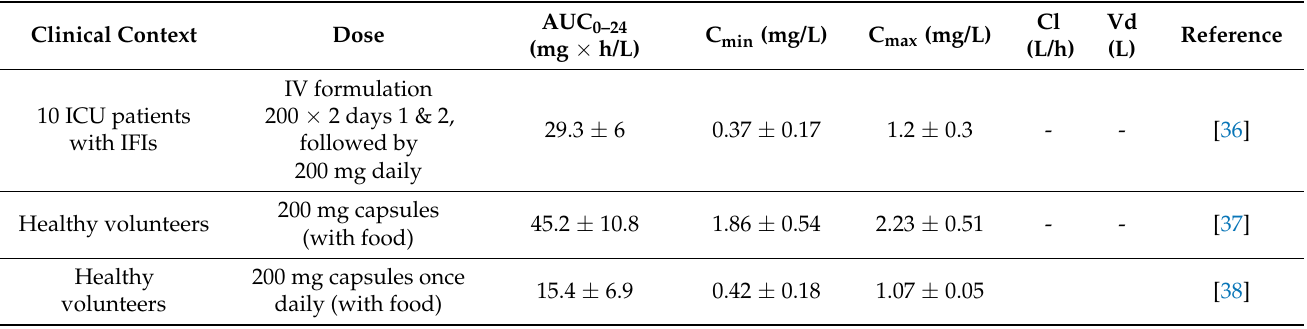
Table 1. Summary of Clinical Studies Assessing PK Parameters of Itraconazole.